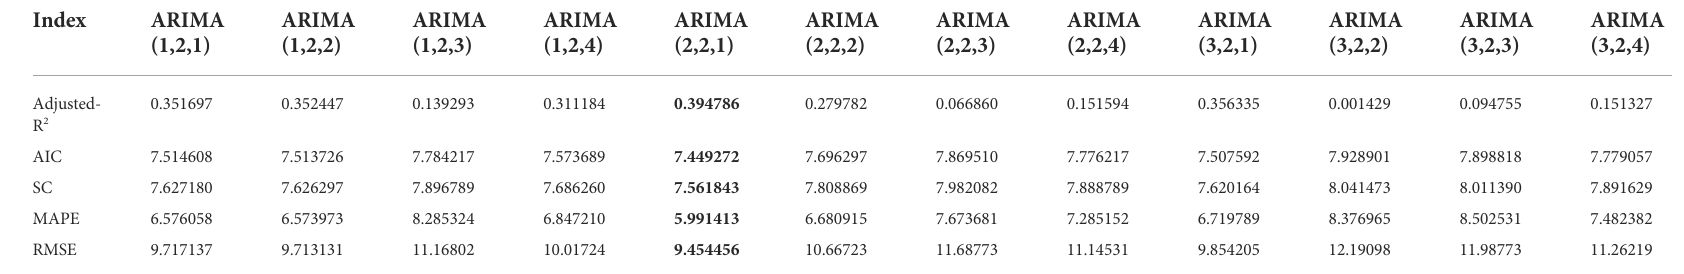
TABLE 5 The parameter comparison of each model ’ s test index.